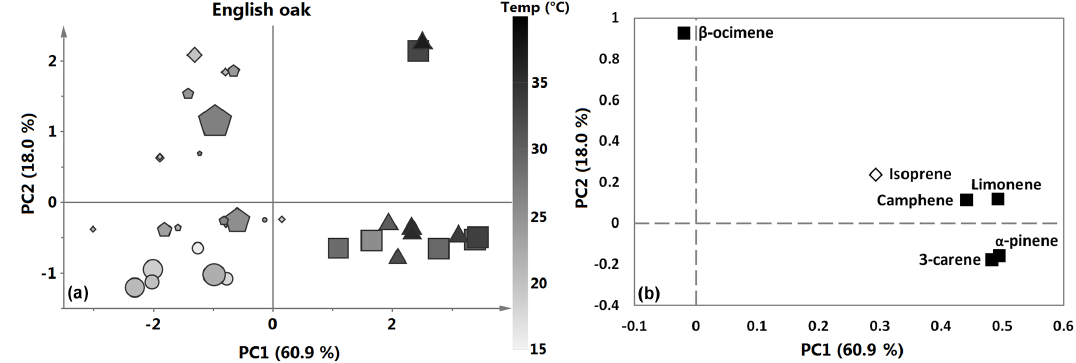
Figure 7. Principal component analysis on the BVOC emission from five cloned English oak trees grown at three sites. (a) The scores of the principal components (PC1 and PC2), and (b) the corresponding loading variables. In (a) , the shading explains the average air temperature. The size of the symbols depicts the average daily PAR level, with an increasing symbol size with increasing PAR levels. The symbols show samples from the different sites (circle = Ljubljana, square = Grafrath tree one, triangle = Grafrath tree two, diamond = Taastrup tree one and pentagon = Taastrup tree two). The explained variance for the different PCs is shown in parentheses.